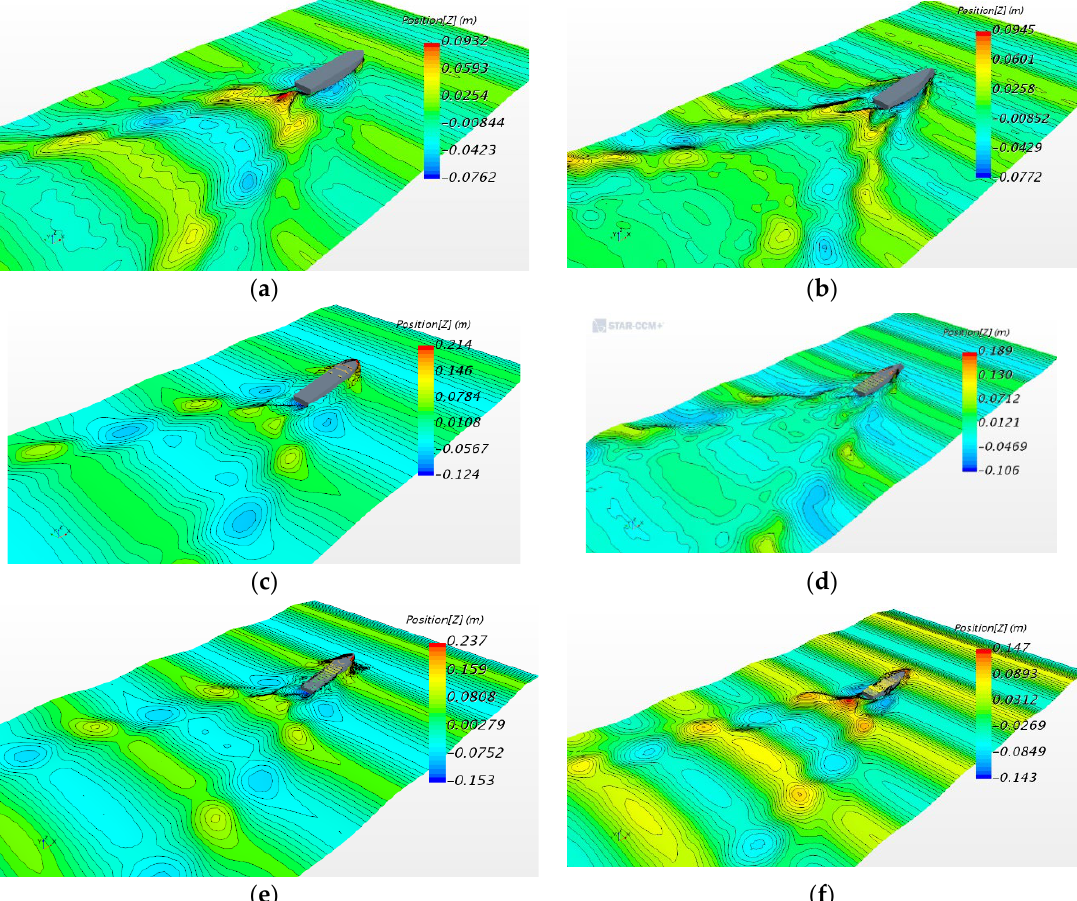
Figure 10. Local flow pattern and the Kelvin wave fields advancing at Fr = 0.5; ( a ) XB1 H = 0.04 (m) λ/L = 1.5 ( b ) XW1 H = 0.04 (m) λ/L = 1.5 ( c ) XB1 H = 0.08 (m) λ/L = 1.5 ( d ) XW1 H = 0.08 (m) λ/L = 1.5 λ /L = 1.5 ( b ) XW1 H = 0.04 (m) λ /L = 1.5 ( c ) XB1 H = 0.08 (m) λ /L = 1.5 ( d ) XW1 H = 0.08 (m) λ /L = 1.5 ( e ) XB1 H = 0.12 (m) λ/L = 1.5 ( f ) XW1 H = 0.12(m) λ/L = 1.5. ( e ) XB1 H = 0.12 (m) λ /L = 1.5 ( f ) XW1 H = 0.12(m) λ /L =